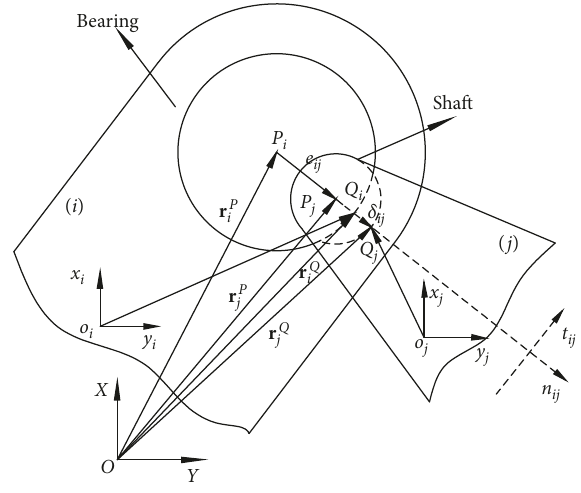
Figure 1: Revolute clearance